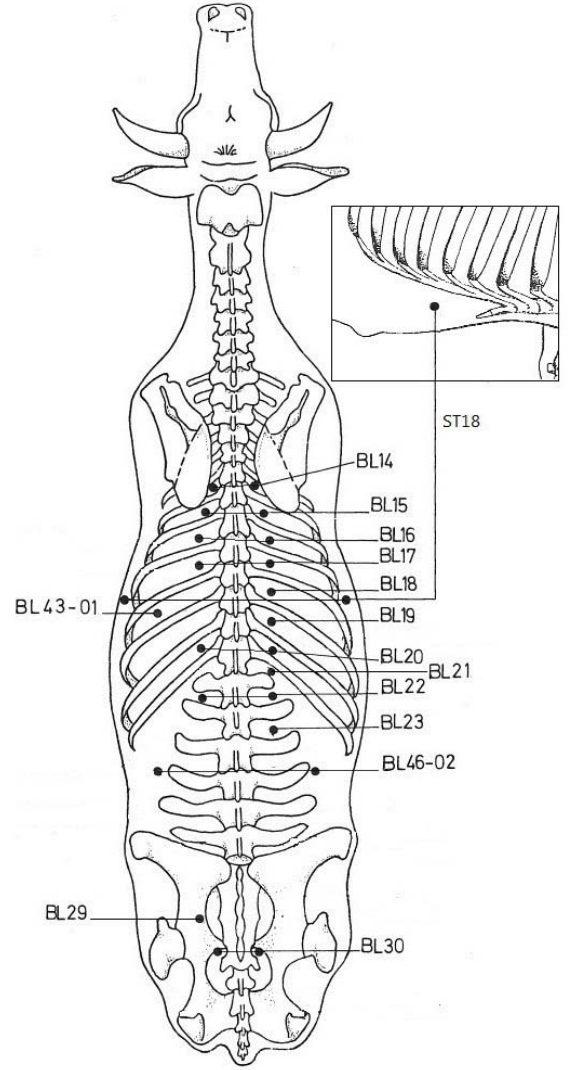
Figure 1. The location of the 24 measured APs (adapted from